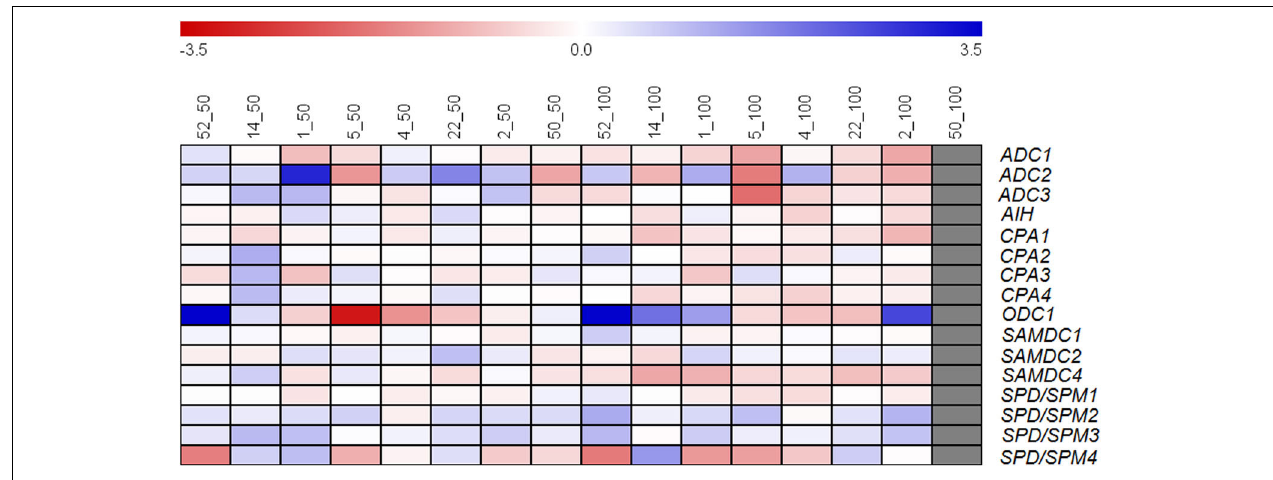
tolerance. Leaves from five different plants were pooled for RNA extraction. Each value represents the mean of three technical replicates. Cultivars are sorted from the most tolerant to the most sensitive from left to right.